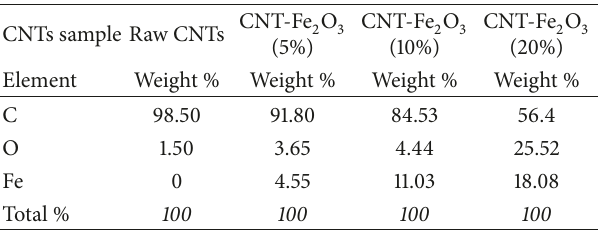
Table 1: EDS analysis of raw CNTs and CNTs with different percent- age of Fe 2 O 3